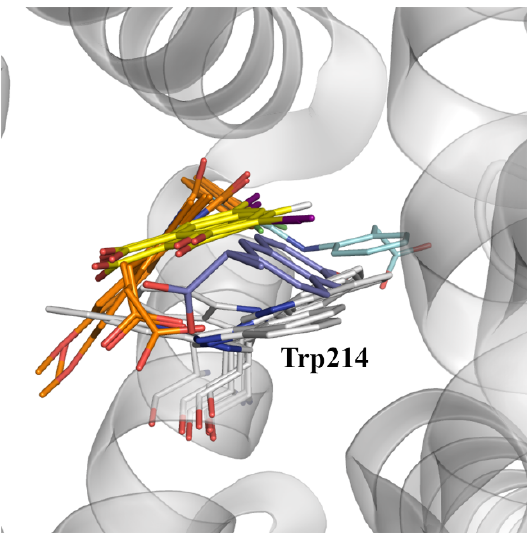
Figure 8. Representation of the binding mode of ( S )-naproxen, indomethacin, 3,5-diiodosalicylic acid, and diclofenac (these ligands are shown as sticks with C atoms in dark blue, orange, yellow, and cyan, respectively) to binding site IIC in albumin (taken from X-ray structures 4OR0, 2BXK, 2BXM, 2BXQ, 4JK4, 4LUH, 5OSW, and 4Z69). The orientation of the side chain of Trp214, which is found in two distinct conformations, is highlighted as sticks. The protein backbone is displayed as a gray cartoon.